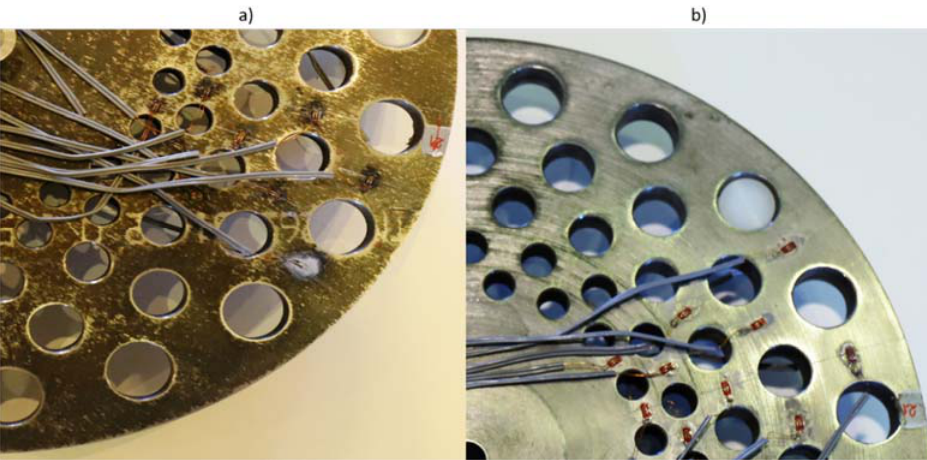
Figure 5: Arrangement of strain gauges on a bimetallic circular perforated plate: a) on the applied layer A – titanium; b) on the base layer B – steel (schematically).